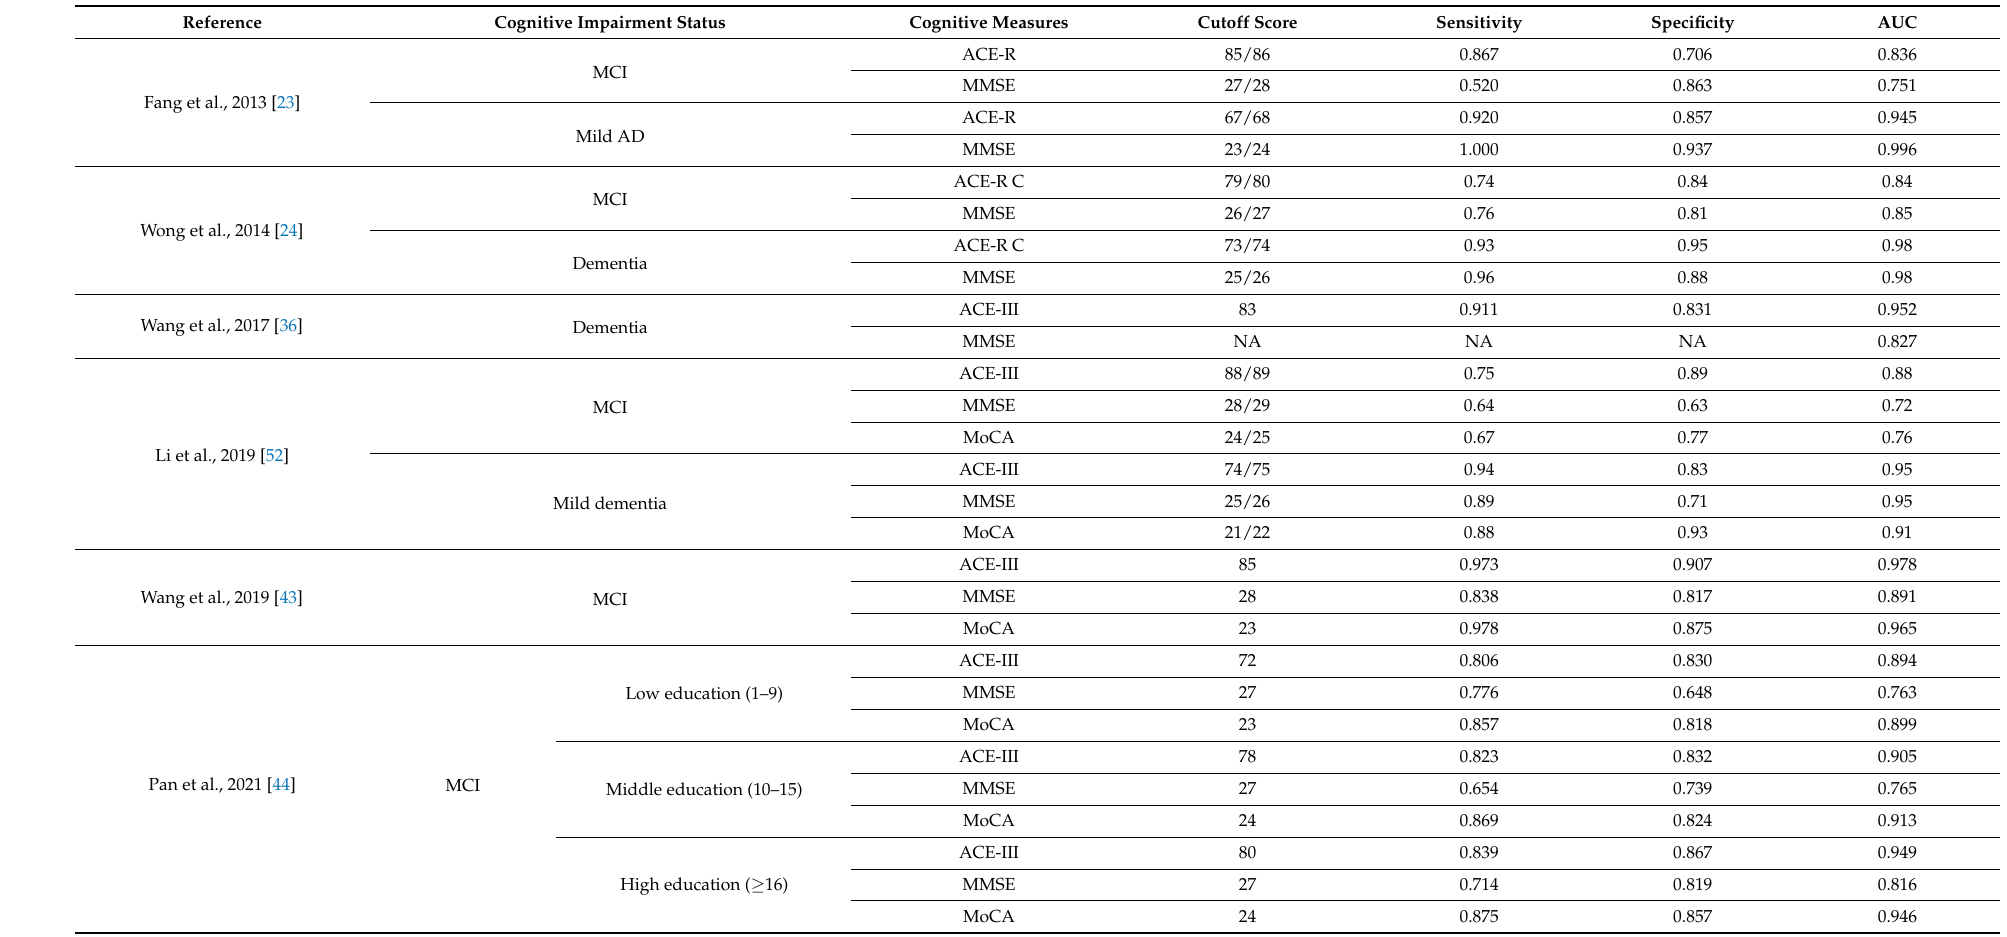
Table 1. Published literature using Chinese versions of